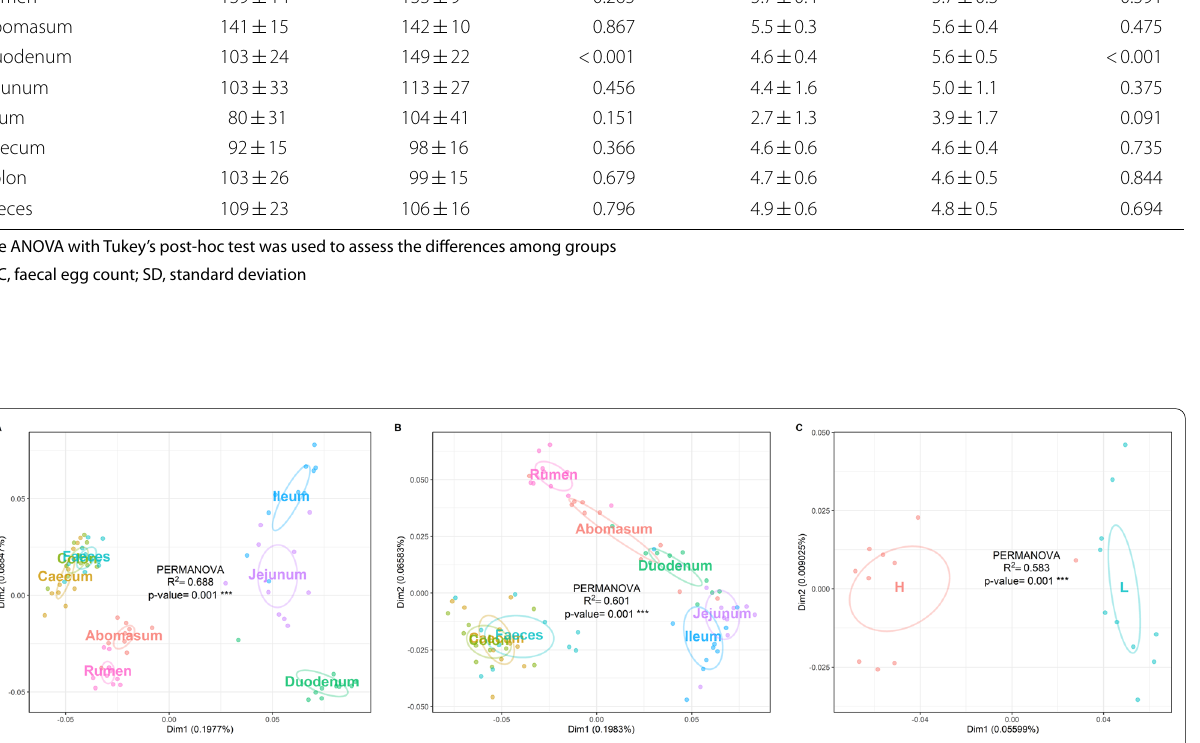
Fig. 5 Principal coordinates analysis (PCoA) based on weighted UniFrac distance matrix data collected along the gastro-intestinal tract (GIT) of A the High-FEC group, B the Low-FEC group, C the High-FEC and Low-FEC groups in the duodenal segment